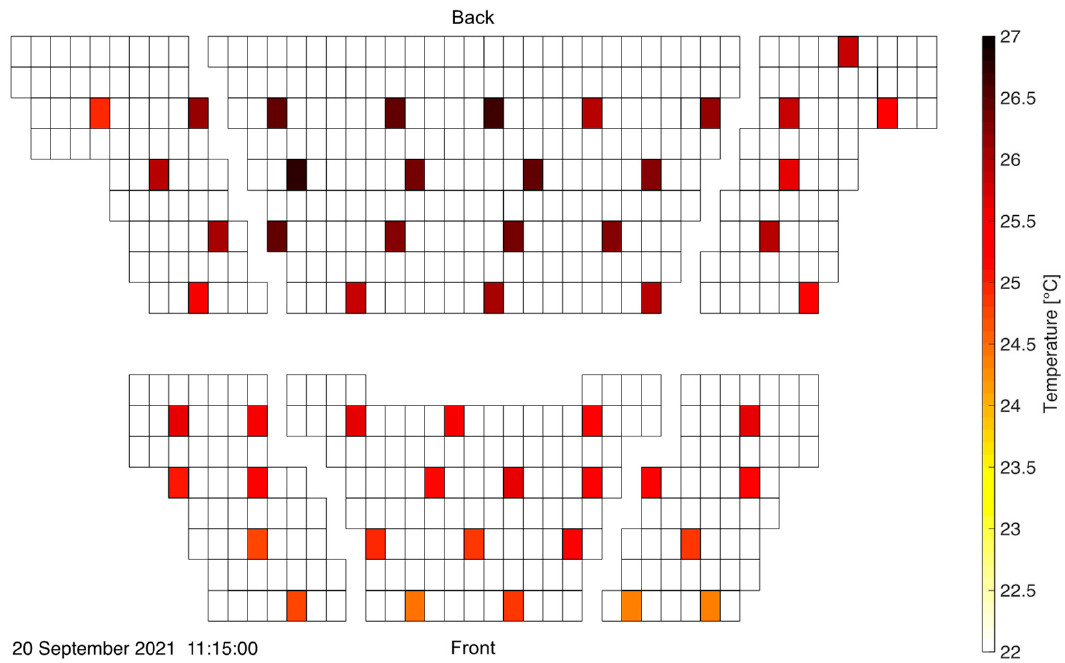
Figure 13. Temperature distribution in the inclined auditorium at the end of the first student event. Highest temperatures are observed in the rear of the room.